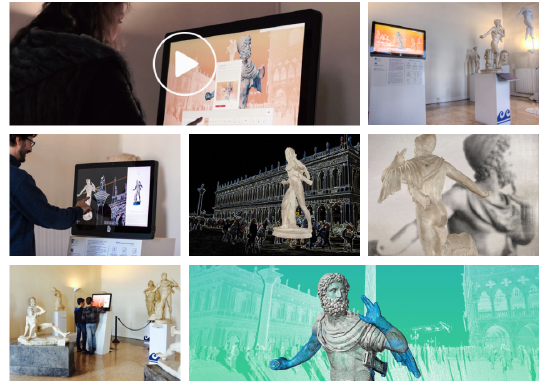
Figure 13. ECH - http://www.ulyssesproject.eu